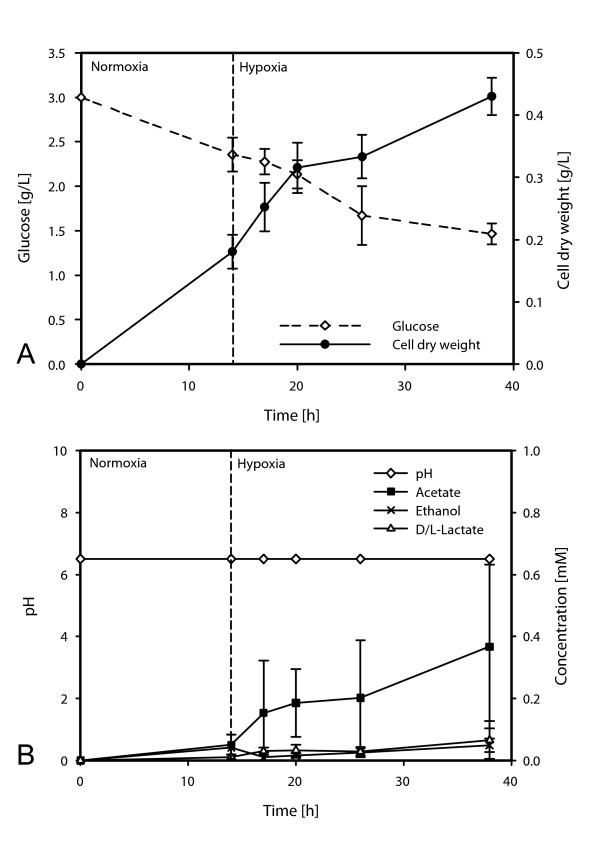
Analysis of Growth Conditions in Oxygen-controlled Fermenter. A) Growth (increase in mycelial dry weight) and glucose consumption (in g/L) of Aspergillus fumigatus during hypoxic cultivation in an oxygen-controlled fermenter. B) Analysis of the pH and the concentration of D/L-lactate, acetate and ethanol (in mM) in the culture supernatant. Data of three fermentation runs are shown. Three liters of AMM was inoculated with 2 × 109 conidia. After a pre-cultivation period under normoxic growth conditions (21% pO2) oxygen supply was shifted to low oxygen levels (0.21% pO2) and samples were taken after 0, 2 (microarray) or 3 (proteomics), 6, 12 and 24 hours.